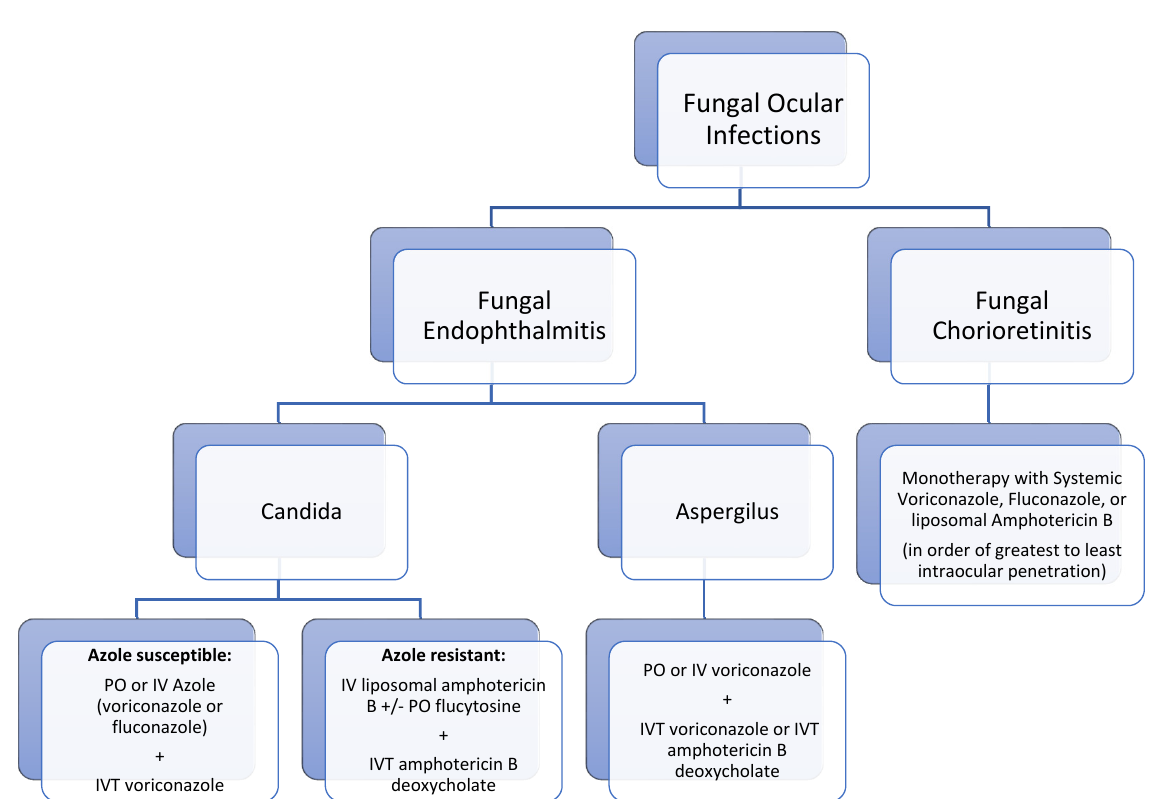
Figure 6. Algorithm for medical management of fungal endophthalmitis. Abbreviations: IVT, intravitreal; PO, oral; IV, intravenous. Systemic fluconazole: 800 mg (12 mg/kg) then 400–800 mg (6–12 mg/kg) daily. Systemic voriconazole: 400 mg (6 mg/kg) intravenous twice daily for 2 doses then 300 mg (4 mg/kg) intravenous or oral twice daily. Liposomal amphotericin B: 3–5 mg/kg intravenously daily, with or without oral flucytosine 25 mg/kg four times daily. Intravitreal amphotericin B: 5–10 µ g/0.1 mL. Intravitreal voriconazole: 100 µ g/0.1